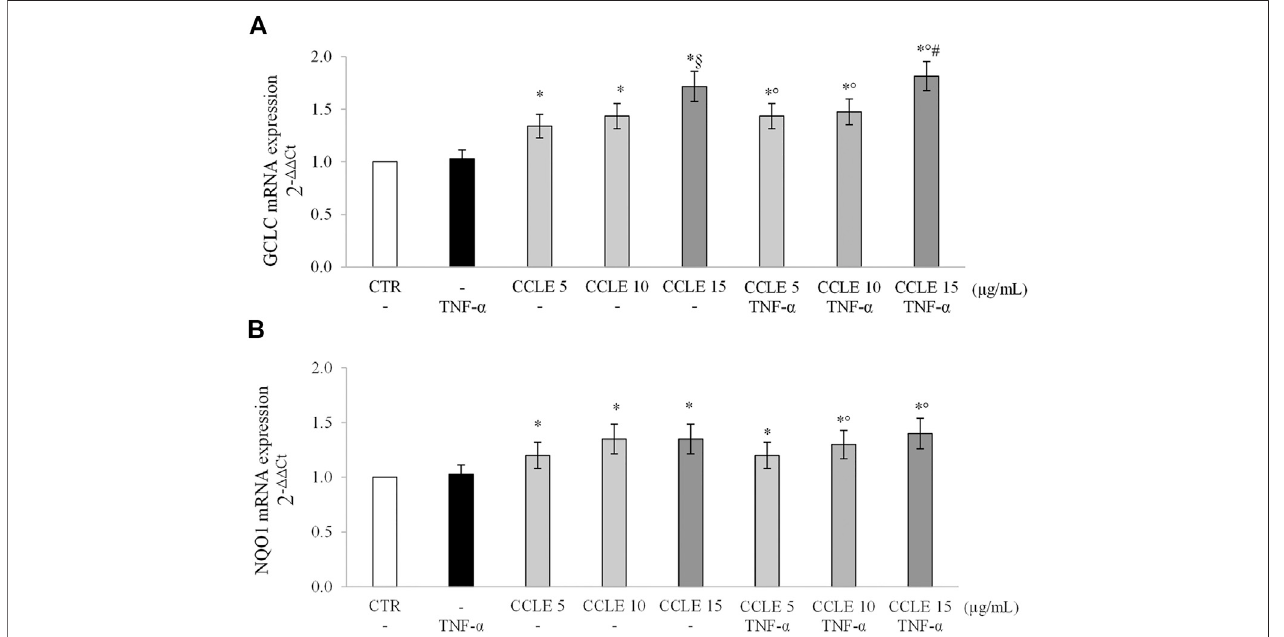
FIGURE 6 | (A) GCLC and (B) NQO1 gene expression. The Caco-2 monolayer was pretreated with CCLE (5-15 μ g/ml) for 24 h, and subsequently exposed to 50 ng/ml TNF- α for 6 h. Cultures treated with the vehicles alone were used as controls (CTR). mRNA expression levels were analyzed by real time PCR and data were expressedas2 − ΔΔ Ct andnormalizedtoCTR.18SrRNAwasusedashousekeepinggene.Results,derivingfromthreeindependentexperiments,arereportedasmean± SD. * p < .05 vs CTR; ° p < .05 vs TNF- α ; § p < .05 vs CCLE 5 μ g/ml; # p < .05 vs lower doses of CCLE + TNF- α